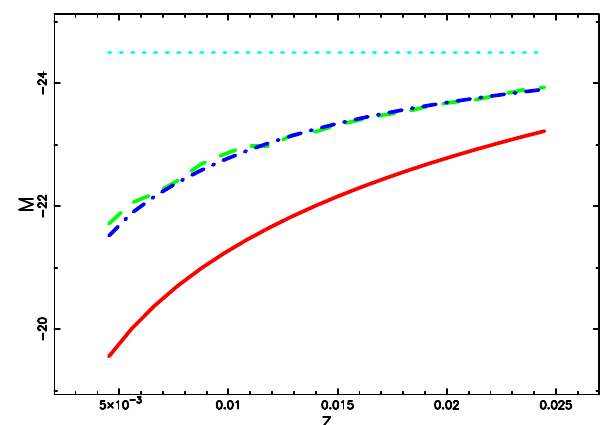
Figure 8. Averaged absolute magnitude of the galaxies belonging to the 2MRS (green-dashed line), theoretical averaged absolute magnitude for the truncated Lindley LF (blue dash-dot-dash-dot line) as given by Equation (39), lower theoretical curve as represented by Equation (55) (red line) and minimum absolute magnitude observed (cyan dotted